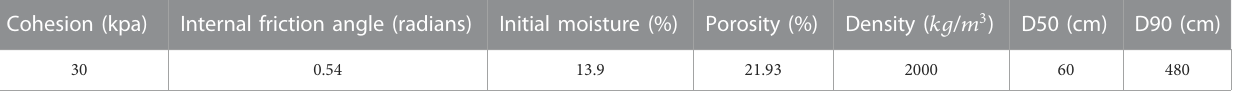
TABLE 6 Calibrated landslide mass parameters in the study